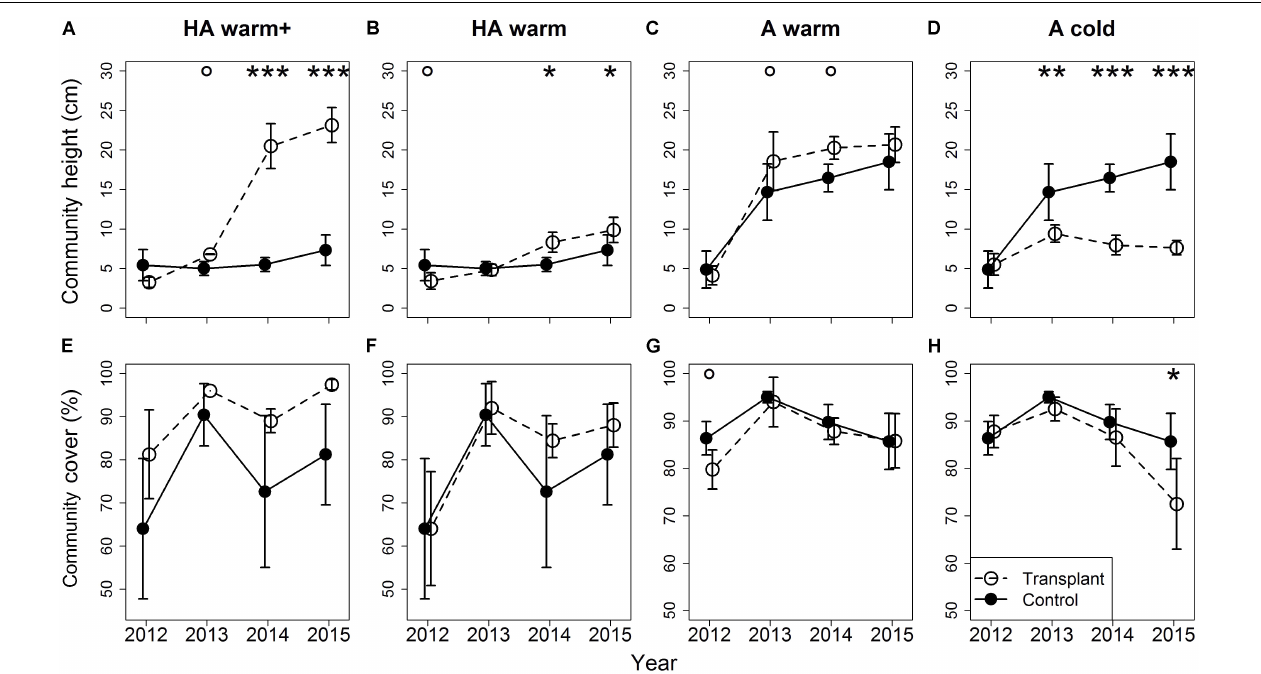
FIGURE 3 | Differences in community height (A–D) and cover (E–H) between transplants at the target sites and controls at the site of origin. Error bars indicate 95% confidence intervals. Significant differences between community height/cover in controls and transplants indicated by asterisks: ∗∗∗ p < 0.001, ∗∗ p < 0.01, ∗ p < 0.05, ◦ p < 0.1. Treatments are indicated by symbols: open symbols and dashed lines for transplants, filled symbols and solid lines for controls at the site of origin. The positions of the different time series are slightly shifted along the x -axis to facilitate